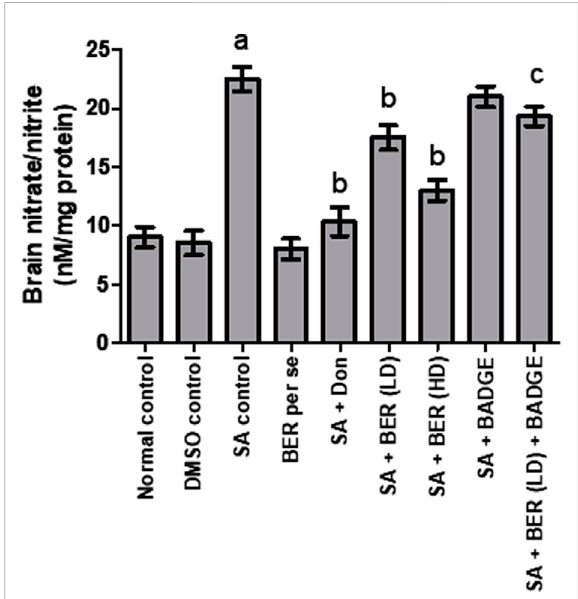
FIGURE 8 Effect of pharmacological interventions on brain nitrite/ nitrate levels. “ DMSO, dimethyl sulfoxide; SA, sodium azide; Don, donepezil; BER, bergenin; BER (LD), bergenin low dose; BER (HD), bergenin high dose; BADGE, Bisphenol A diglycidyl ether ” (Mehra et al., 2015). “ Each group ( n = 6) represents mean ± S.E.M, a = p ˂ 0.05 vs. normal control, b = p ˂ 0.05 vs. normal control, c = p ˂ 0.05 vs. SA control. One-way ANOVA followed by Bonferroni ’ s multiple range test.